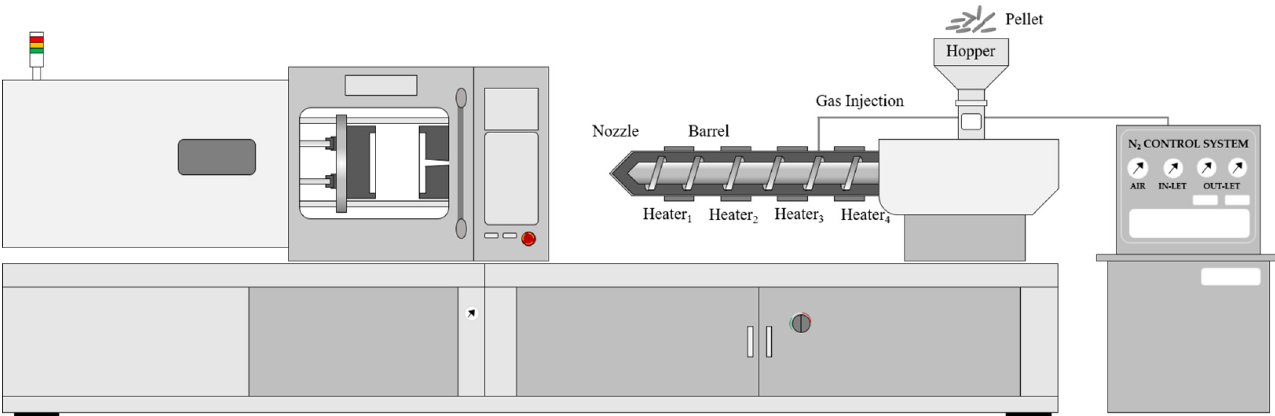
Figure 1. Schematic of injection molding machine of conventional and foam injection method. Two injection methods were used: the conventional injection method and foam injec-